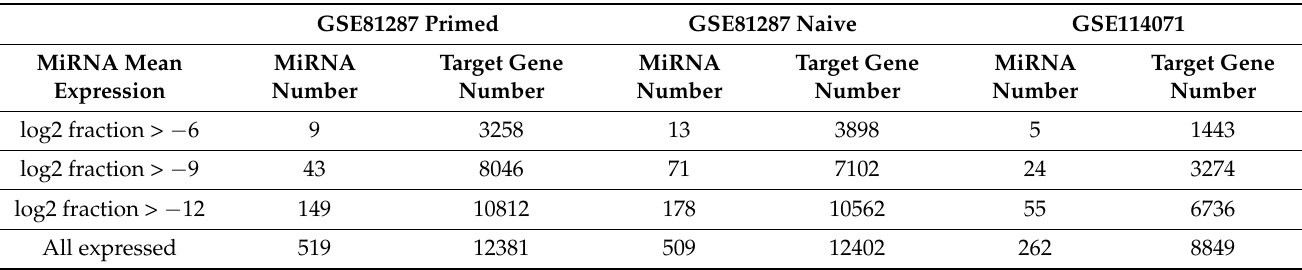
Table A1. The numbers of miRNAs and target genes in GSE81287 and GSE114071. Target genes of multiple miRNAs are the union of target genes of each